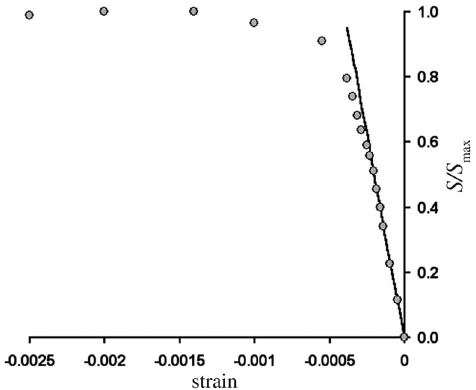
Fig. 4. Scaling factor γ with respect to the normal- ized stress.